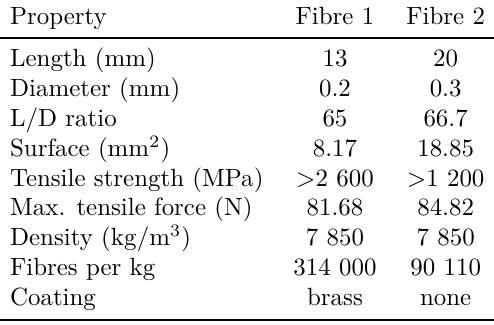
Table 2. Properties of steel fibres used.